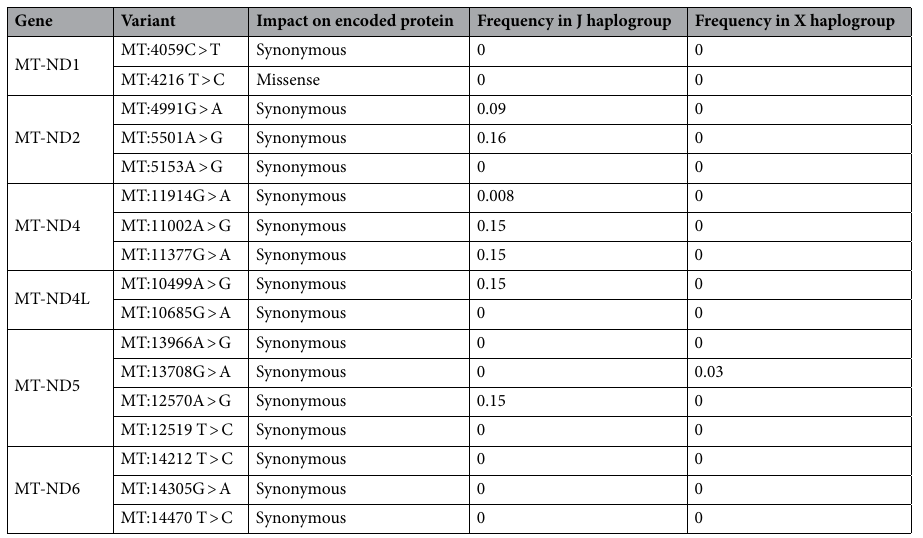
Table 5. List of the prioritized variants in NADH dehydrogenase subunit genes which can influence their gene function and are associated with body fat mass and obesity in Qatari